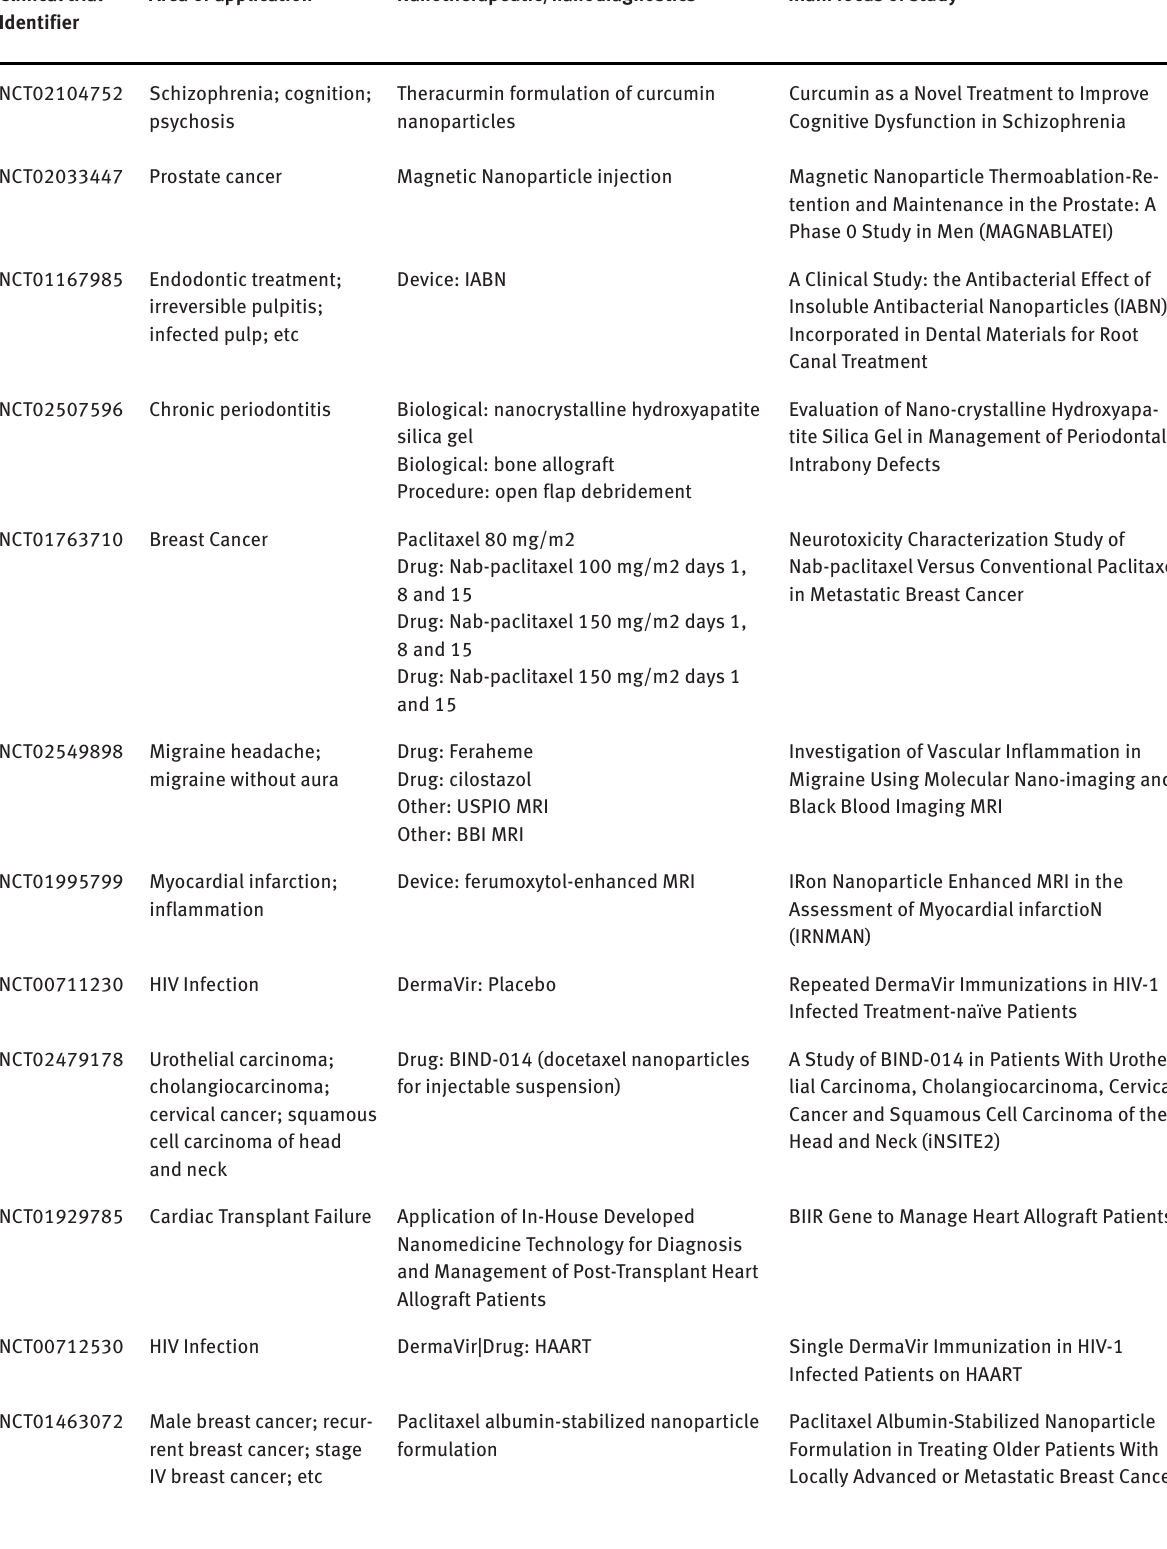
Table 4: Some clinical trials in nanomedicine Clinical trial